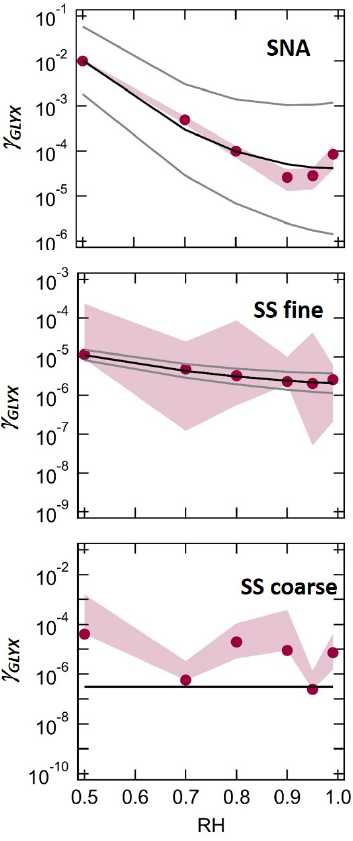
Figure 2. Calculated reactive uptake coefficients for uptake of methylglyoxal to sulfate/nitrate/ammonium (SNA) and sea salt (SS) aerosols. See text for